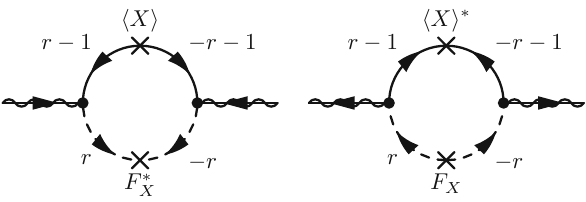
Fig. 2 One-loop diagrams for the gaugino mass in ordinary gauge mediation models, with R-charges of messenger components deter- mined from R-charge conservation. The two diagrams are conjugate to each other, and both should be included as Majorana mass terms